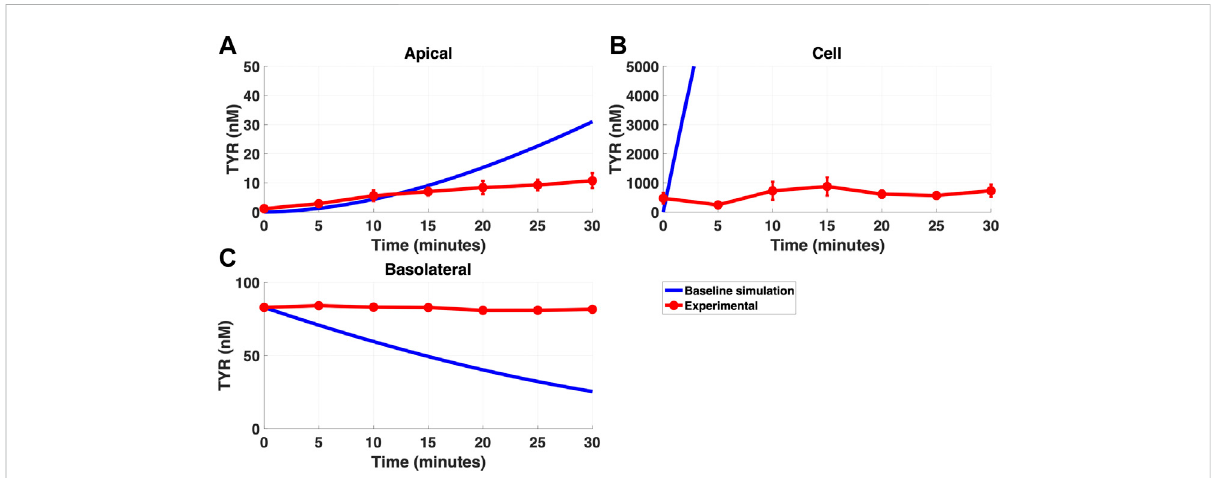
FIGURE 2 The baseline model does not recapitulate experimental data for TYR transport following basolateral loading. The transport of 82.9 nM TYR across Caco-2 cells was modeled for basolateral loading by solving Eqs 4 – 6, using the values mentioned in Supplementary Table S2, using MATLAB vR2021a.Comparisonsweremadebetweenthebaselinemodel(representingknownTYRtransportersthathavebeencharacterized;bluecurve)for the apical Panel 2 (A) , cellular Panel 2 (B) and basolateral compartments Panel 2 (C) , versus experimental observations; red curves (Sarkar and Berry, 2020). Kinetic parameters used for this modelling were: V max_OCT2 = 0.1 nM/s, K t _OCT2_apicaltocell = 101.5 nM, V max_baso_active = 43.0 nM/s and K t_baso_active = 33.1 nM.